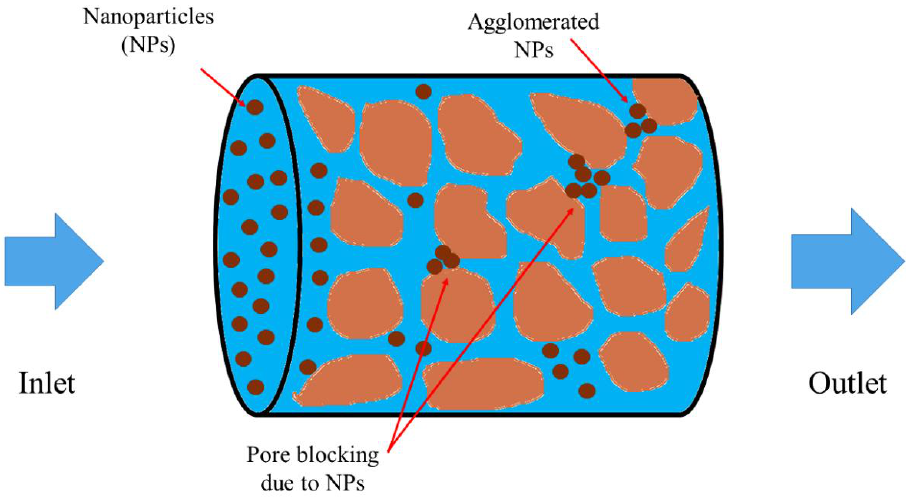
Figure 2. Nanoparticle agglomeration and retention lead to pore blockage in reservoir core sample.